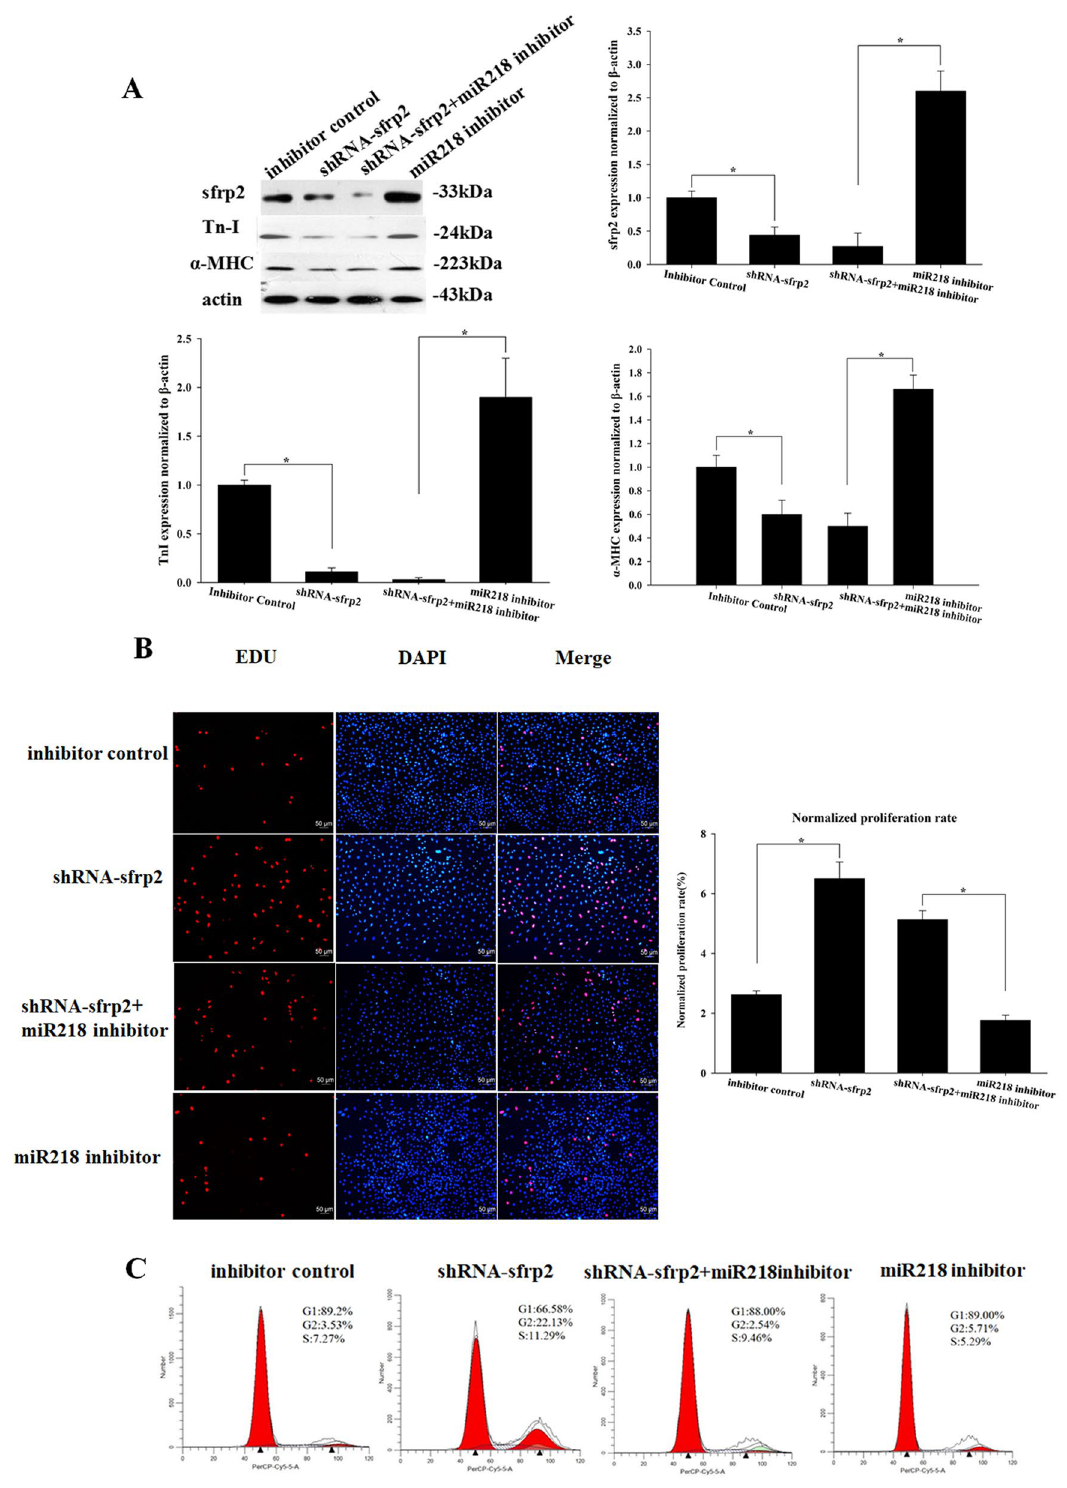
Figure 4. MiR218 regulates cell proliferation and differentiation by targeting sFRP2. ( A ) Western blot analysis of proteins from CSCs transfected with sFRP2 shRNA, the miR218 inhibitor + sFRP2 shRNA and the miR218 inhibitor and subsequently cultured in differentiation media for 12 days. The protein profiles were normalized to β-actin. ( B ) The cells were stained with EdU and Hoechst 33342. ( C ) Cell cycle distribution of CSCs after transfection with sFRP2 shRNA, the miR218 inhibitor + sFRP2 shRNA and the miR218 inhibitor for